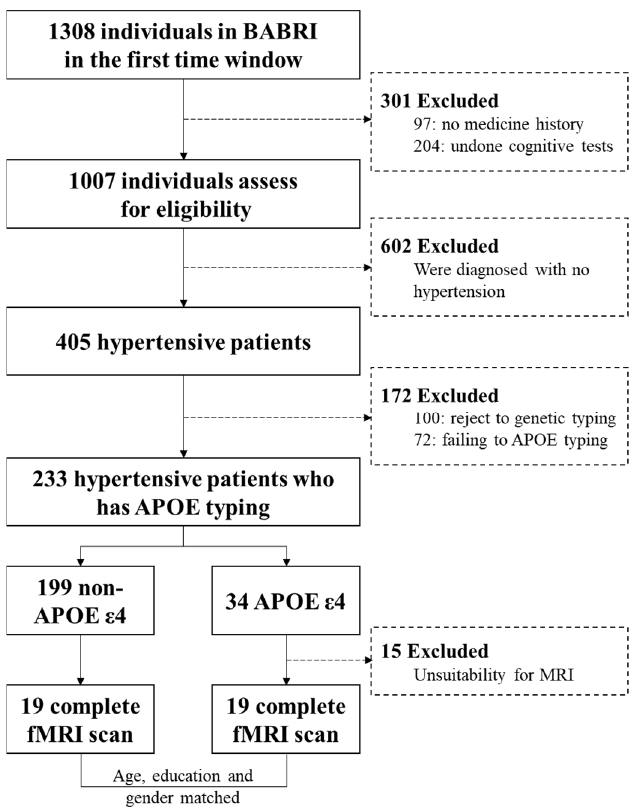
Figure 1. Participant flow chart. BABRI: Beijing Aging Brain Rejuvenation Initiative; APOE: Apolipoprotein E; fMRI: functional magnetic resonance imaging; MRI: magnetic resonance